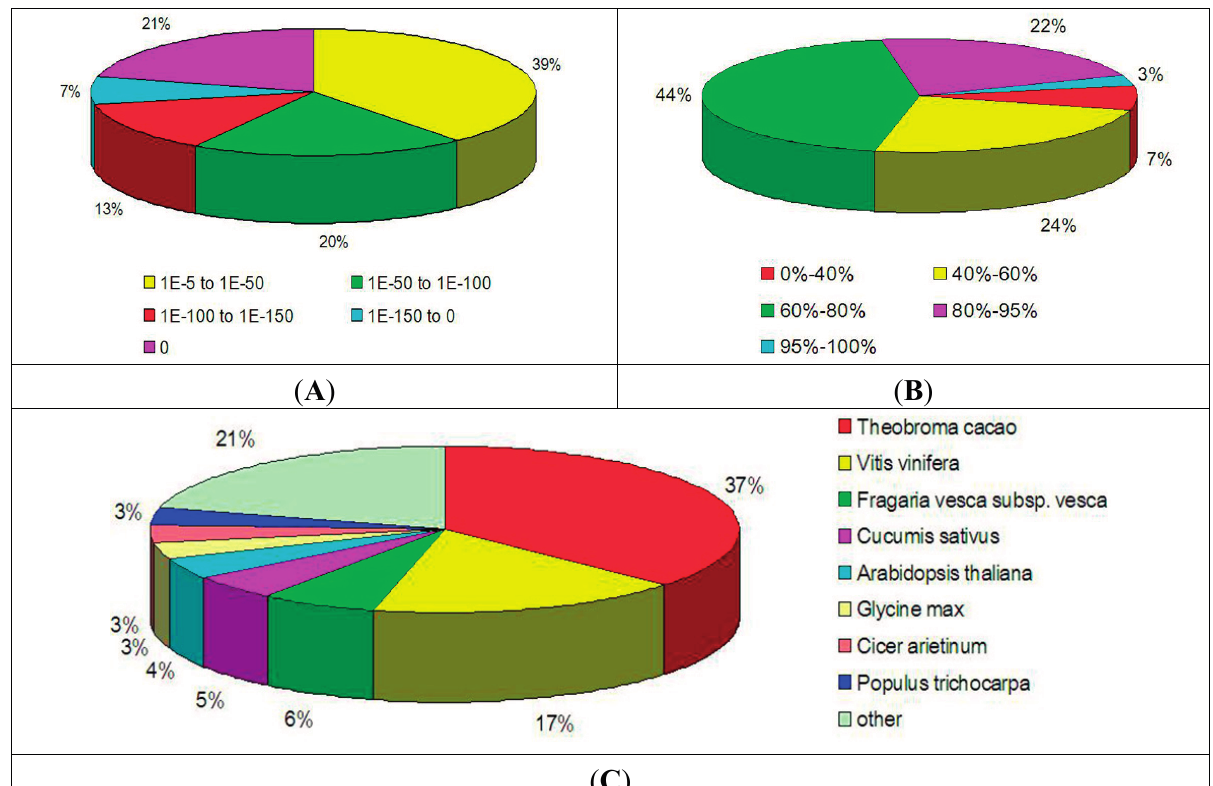
Figure 1. Characteristics of homology search of litchi pericarp unigenes against the NR database. ( A ) E-value distribution of the top BLAST hits for each unique sequence; ( B ) Similarity distribution of the top BLAST hits for each unique sequence; ( C ) Species distribution of the top BLAST hits for all homologous